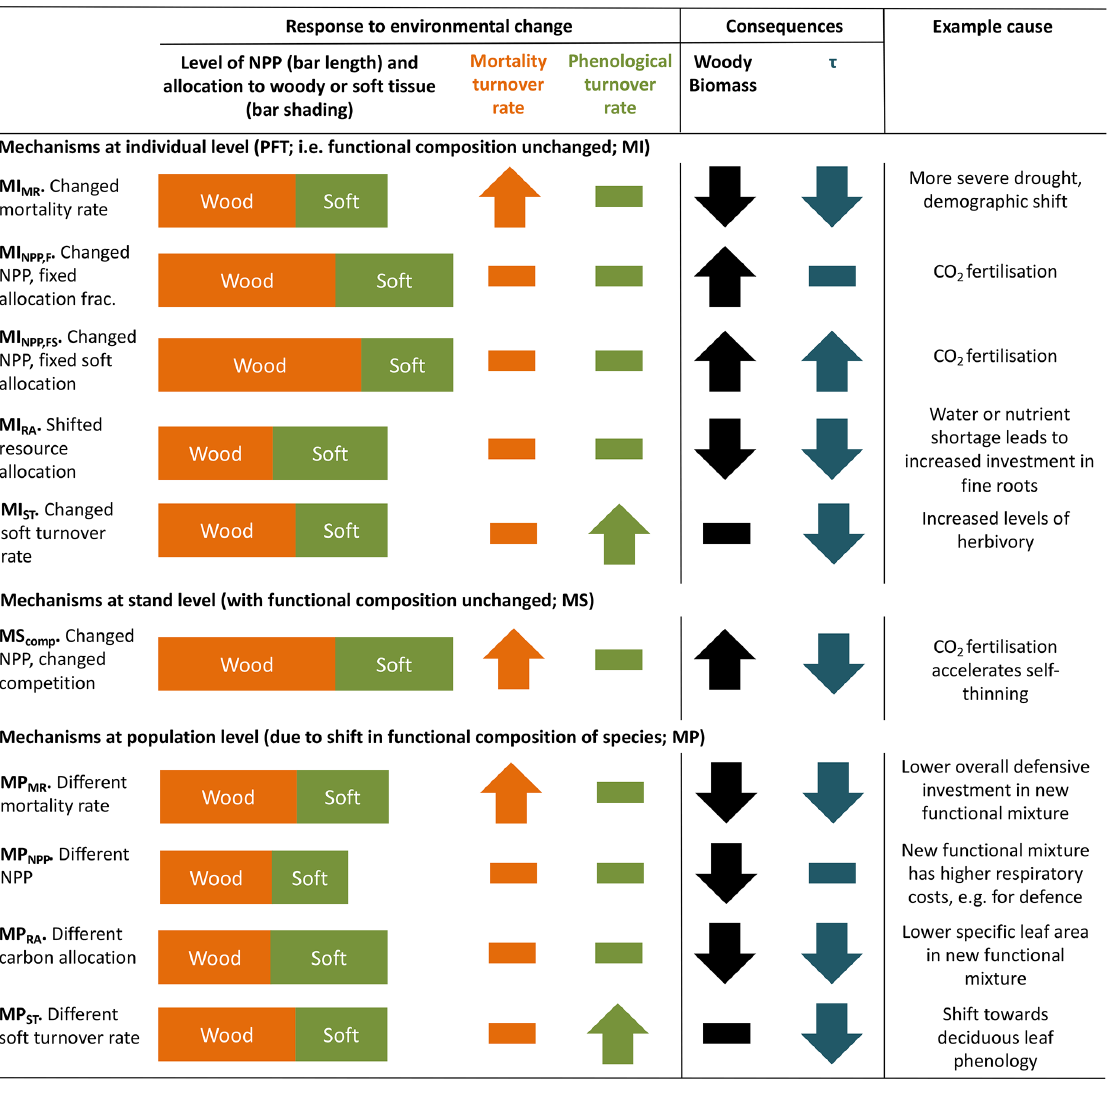
Table 1. Conceptualisation of mechanisms by which biomass stock or τ can be modified as a result of environmental change. Many of these mechanisms may respond in concert to a given driver. Mechanisms are grouped by those related to the existing functional composition of trees and those related to a change in tree functional composition. The change in woody biomass and τ due to a change in NPP, resource allocation, mortality turnover rate or phenological turnover rate is illustrated. A dash indicates no change. Examples are only illustrative; the same mechanism could result from many scenarios, and the listed examples may also influence other mechanisms. Further, the change for each mechanism is conceptualised in a particular direction, consistent with the given example, but could equally apply in reverse. For instance, MI MR could also be shown with a decreased mortality rate, leading to increased biomass and τ . The groupings correspond to those commonly used in TBMs, with “mortality” referring to turnover from wood resulting from tree death and “phenological” referring to turnover of “soft” tissues, which include leaves, fine roots and fruits. For simplicity, rapidly turned-over components such as root exudates and biogenic volatile organic compound emissions, which are rarely explicitly represented in TBMs, are lumped into the categories soft and phenological for allocation and turnover, respectively, although it is noted that some TBM parameterisations may implicitly include the lost carbon in respiration fluxes. Codes (e.g. MI MR ) are introduced and used in the main text to refer to the individual